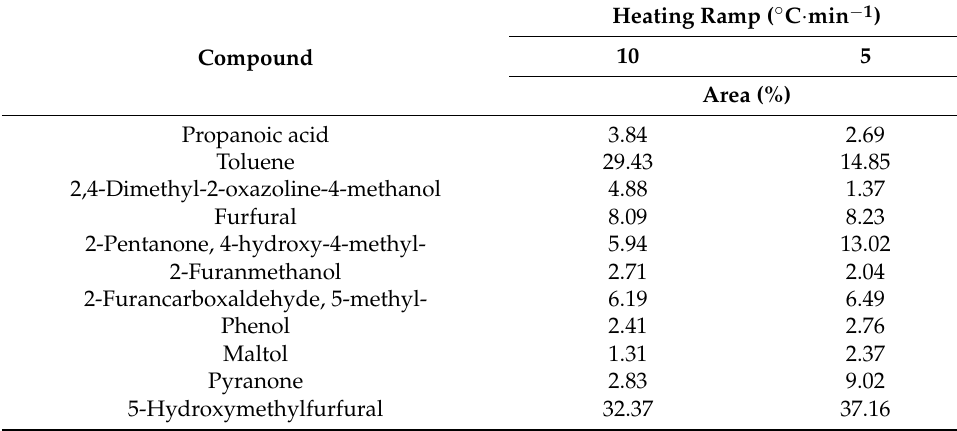
Table 8. Compounds detected in orange waste bio-oils chromatograms and their relative area percentages using different heating ramps in the pyrolysis.